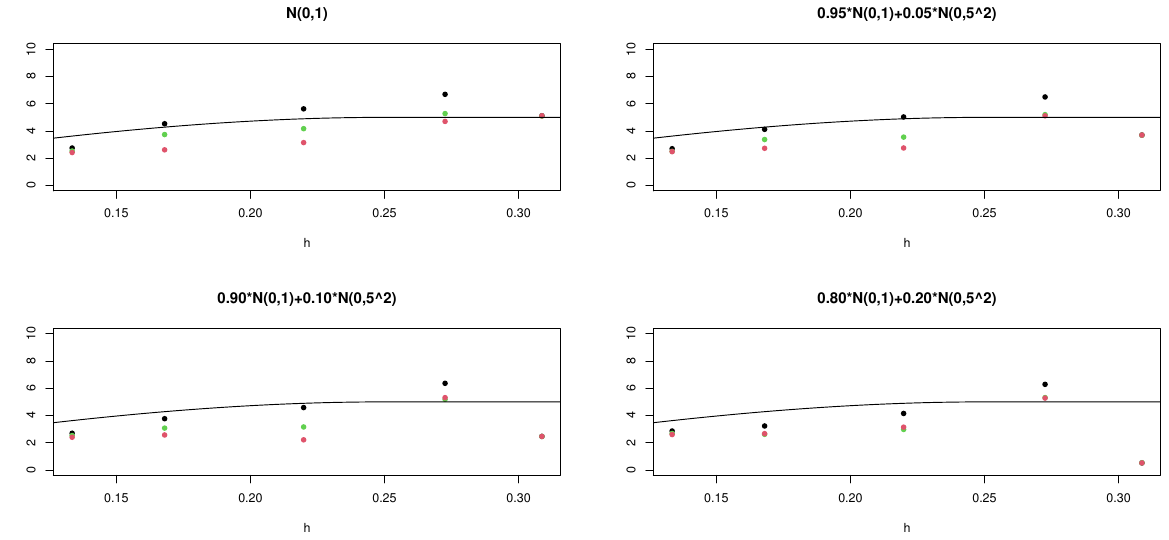
Figure 4. Variogram estimations of Example 1: classical (black), 0.1-trimmed (green) and Huber’s (red), and the variogram model with no